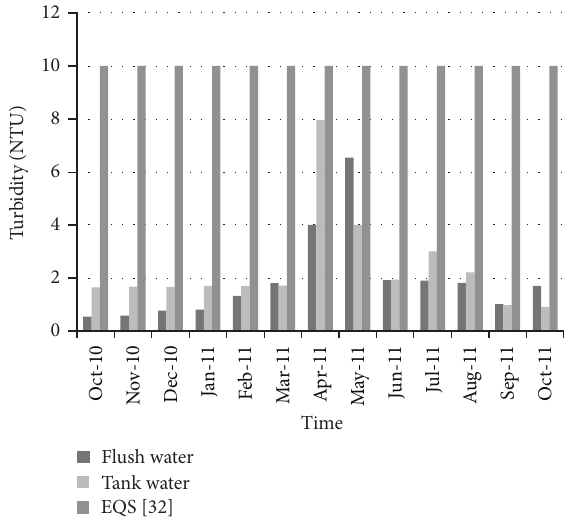
Figure 13: Variation of turbidity over time.